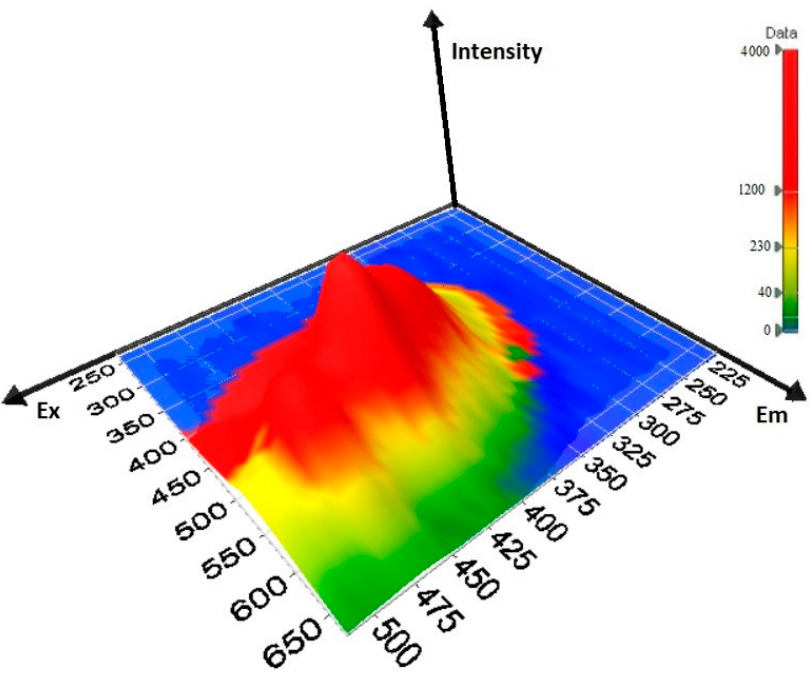
Figure 1. Characteristic 3D-EEM spectra of thyme honey.